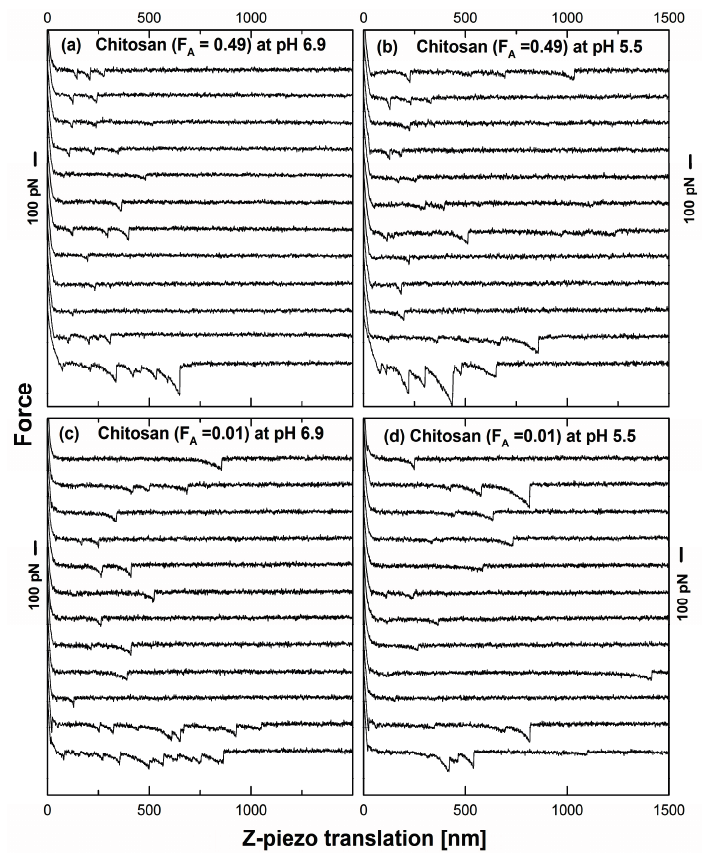
Figure 3. Force-distance retraction curves obtained for pig gastric mucin covalently attached to mica and chitosan covalently attached to the AFM tip. The force distance data were collected in an aqueous solution on a high-precision mapping stage. The measurements were conducted in a buffered aqueous solution (25 mM buffer, 150 mM NaCl, pH 6.9, or 25 mM acetate buffer, 150 mM NaCl, pH 5.5). The galleries of force distance curves are shown for the mucin interacting with chitosan with F A = 0.01 and F A = 0.49 at pH 5.5 and 6.9. Data are shown only for the retract directions from the surface and are shifted to the vertical direction for better